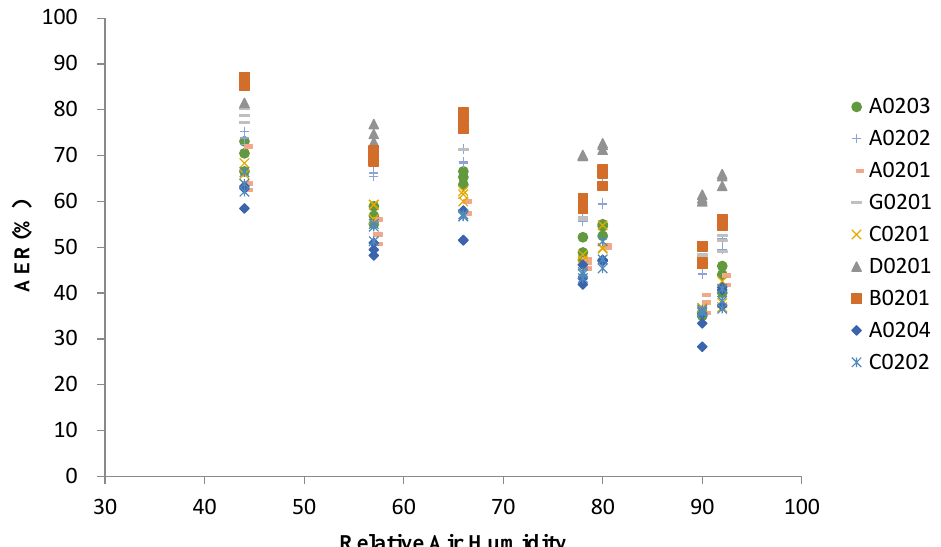
Figure 6. Relationship between AER of insecticide and relative air humidity. On the basis of correlation analysis between insecticide samples and atmospheric pressure (Figure 7), it can be seen that the AER of all types demonstrated a significant negative correlation with the change of atmospheric pressure, and the correlation between AER value and atmospheric pressure of the same formulation showed similar trend curves. Among all the samples, the AERs of B0201 were decreasing more sharply with the increase of atmospheric pressure than other samples, and the trend curves of SC formulations of C0201, C0202 and EC formulation of A0204 were drawn very close.